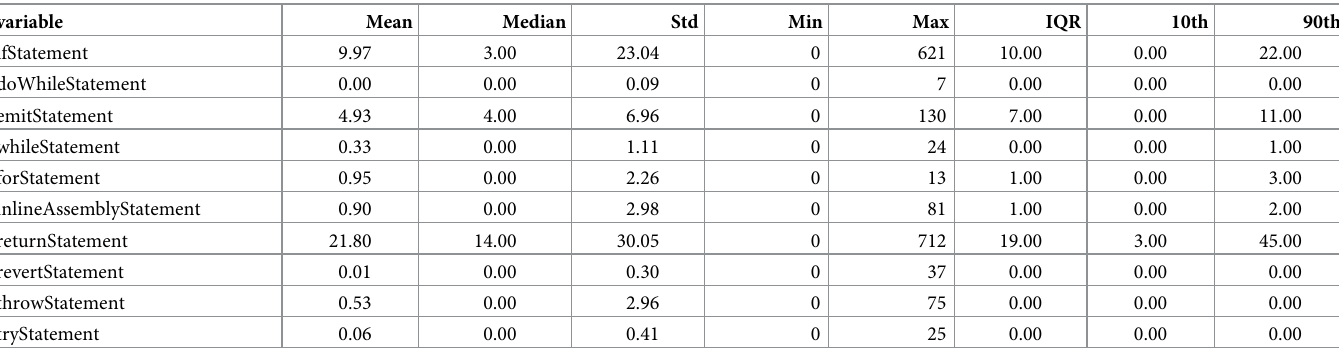
Table 2. Statements statistics computed for all the Smart